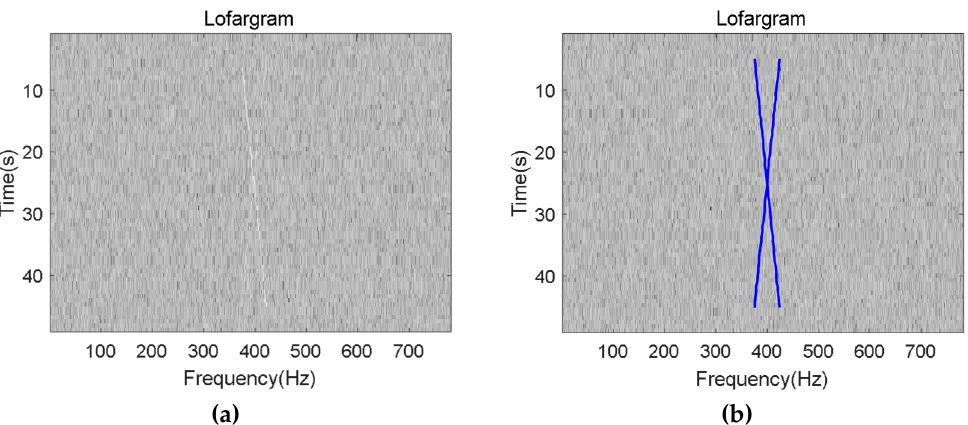
Figure 17. Detection result of the cross-signal: (a) Lofargram after background equalization; (b) The detection result.